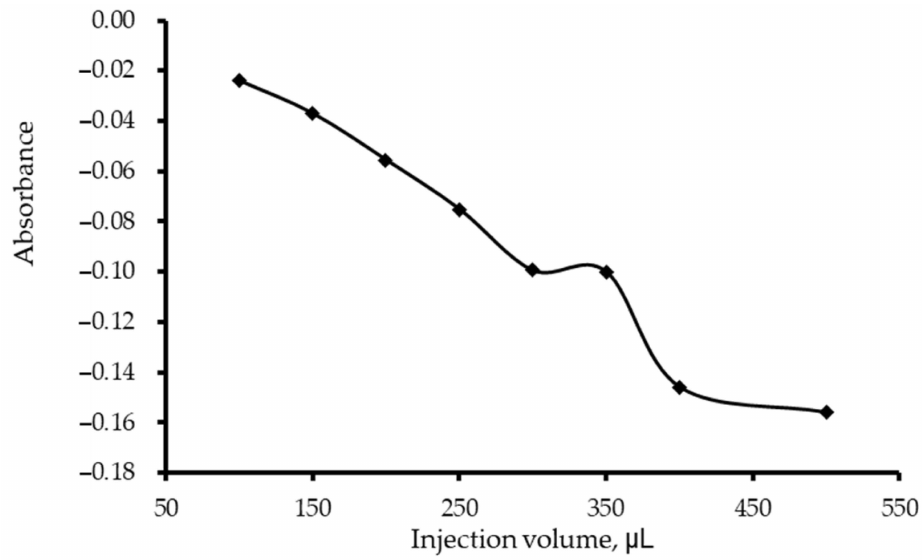
Figure 7. Effect of injected sample volume on the absorbance drop. The sample flow rate of 3.5 mL min − 1 , CTAB concentration of 30 µ g mL − 1 , and measurement at 430